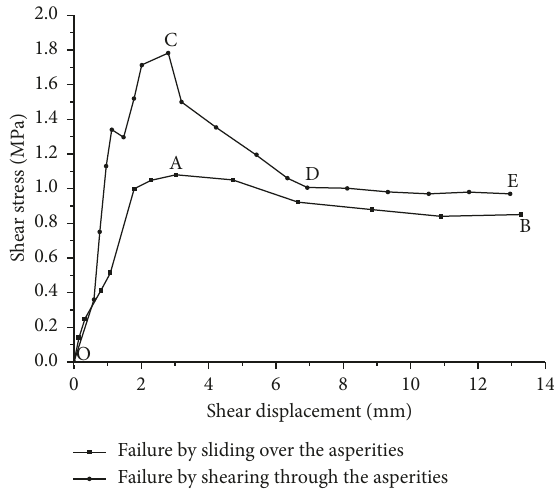
Figure 8: The curve of two failure modes of discontinuity.